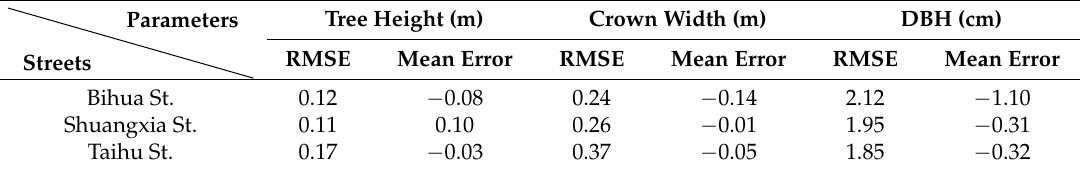
Table 6. RMSEs and mean errors for morphological parameters of each street.